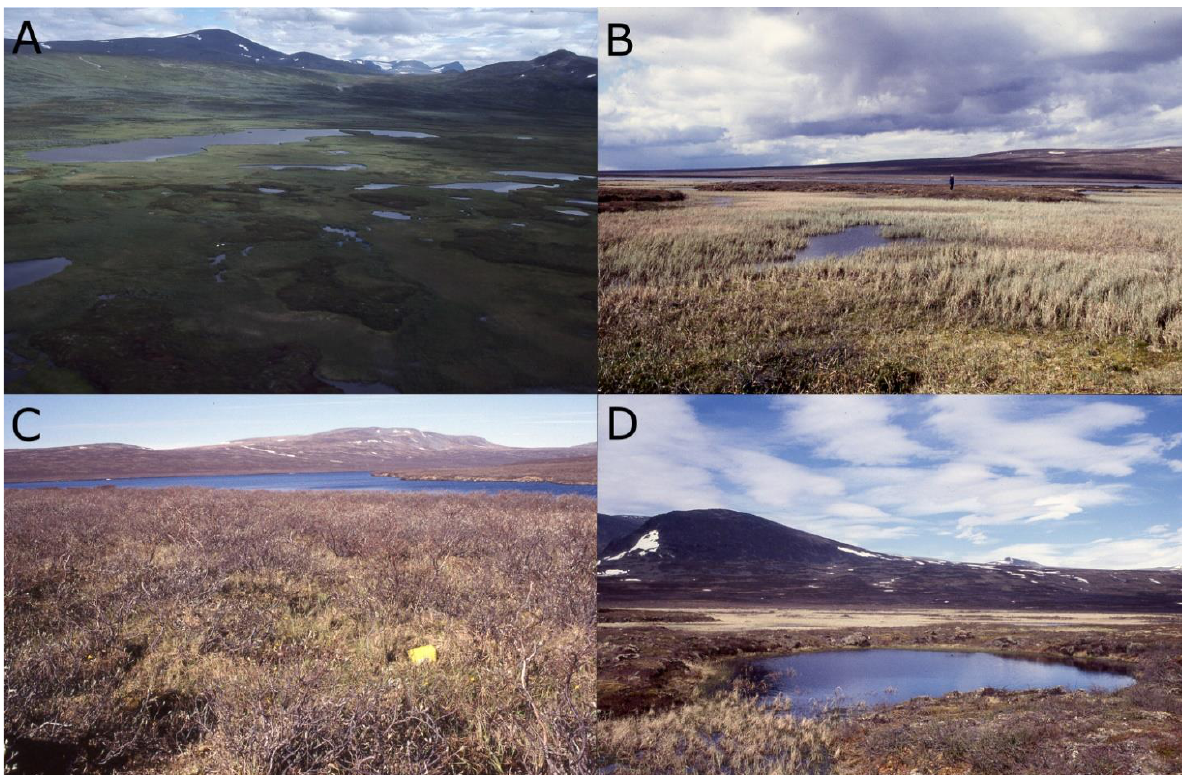
Figure 2. Habitat of Platycheirus torei in Seitajaure, Sweden: (A) Aerial photo of the Seitajaure palsa mire, July 1999; (B) mire with a large mature palsa, June 1996; (C) Willow shrub along the border of the palsa mire, with yellow pan trap, June 1996; (D) Remnant palsa with open pond, June 1996.